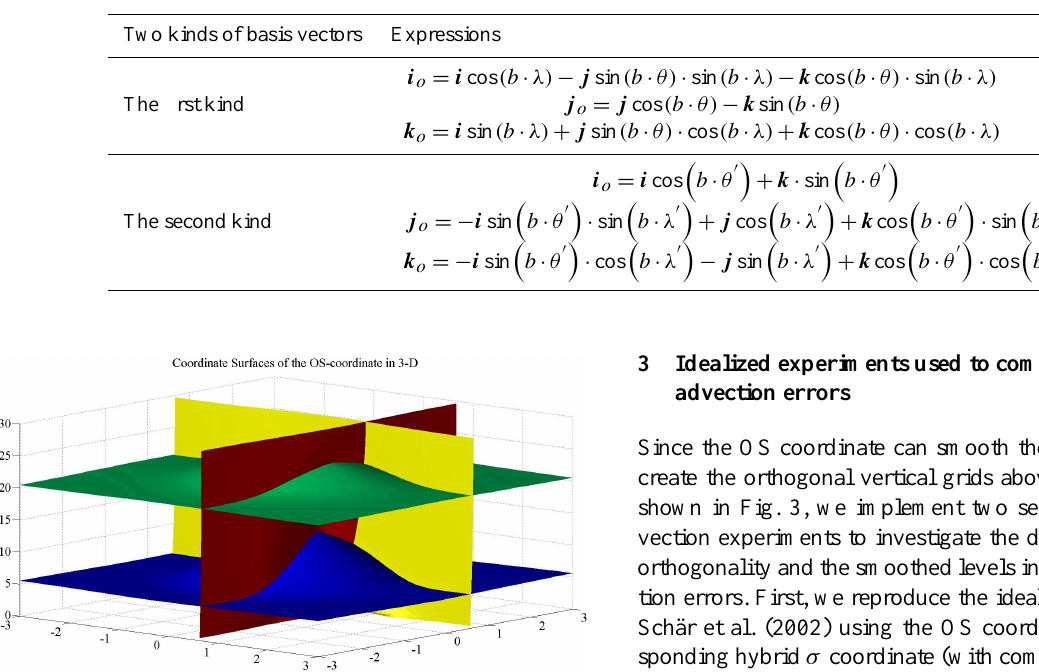
Table 1. Basis vectors of the OS coordinate.